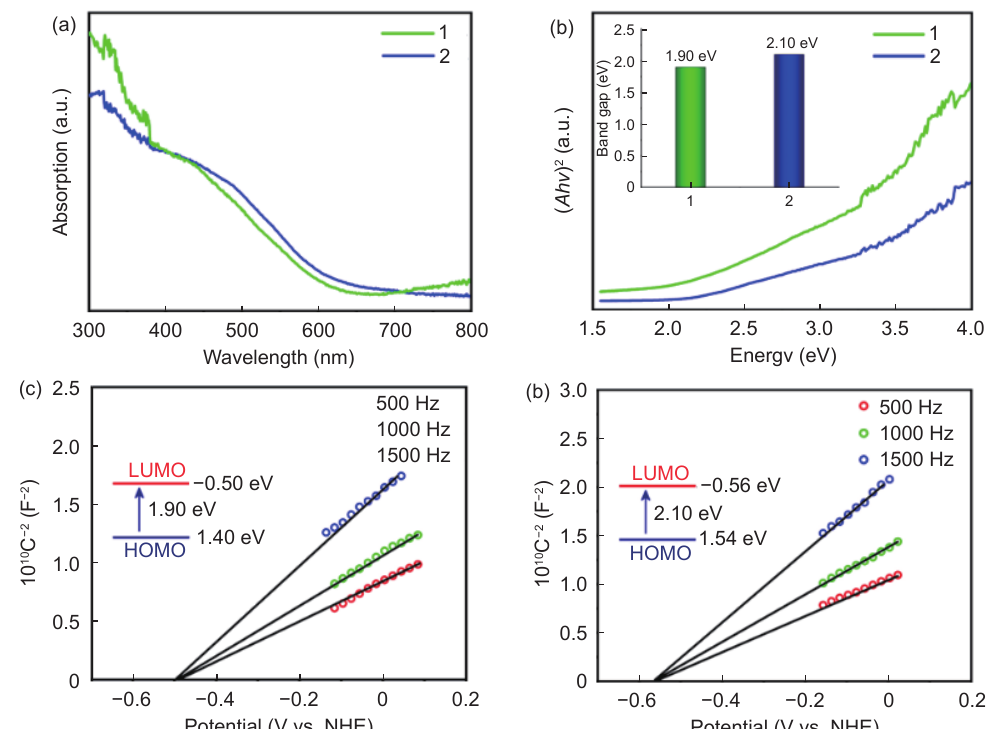
Figure 4 (a) Solid-state UV–vis spectra of 1 and 2 . (b) Their transformation based on the Tauc plot function. Inset: calculated optical band gaps of 1 and 2 . (c) and (d) Mott–Schottky plots of 1 and 2